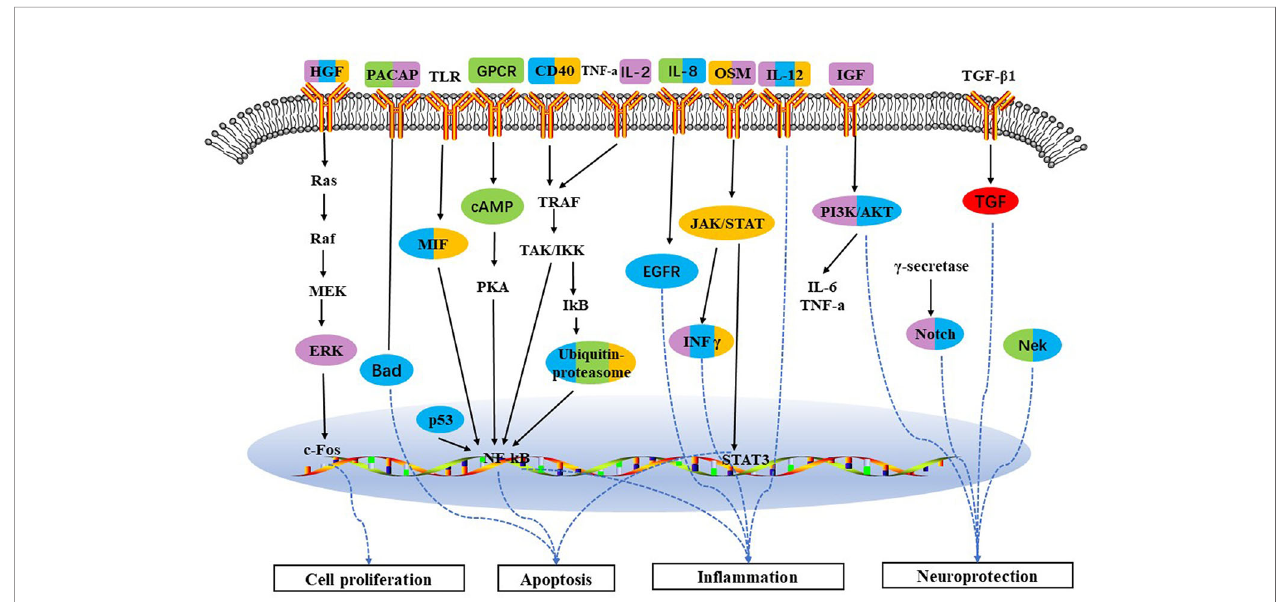
FIGURE 7 | Schematic depicting target pathways identi fi ed for the fi ve groups in treatment of cerebral ischemia. Pathways which are triggered by BA, JA, UA, BJ, and JU are labeled with red, orange, purple, green, and blue, respectively. Overlap of colors indicates the cotarget pathway for each